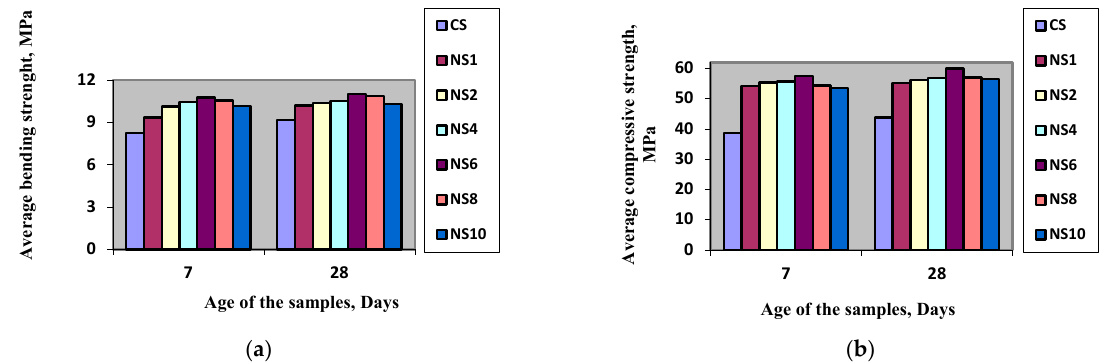
Figure 2. Compressive and bending strength of mortar containing Nano-silica.